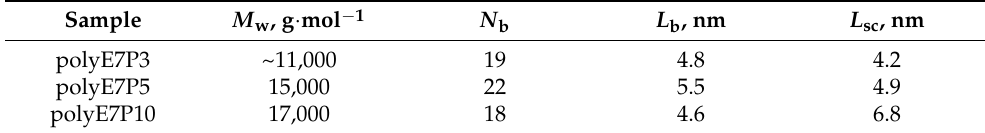
Table 2. Structural characteristics of